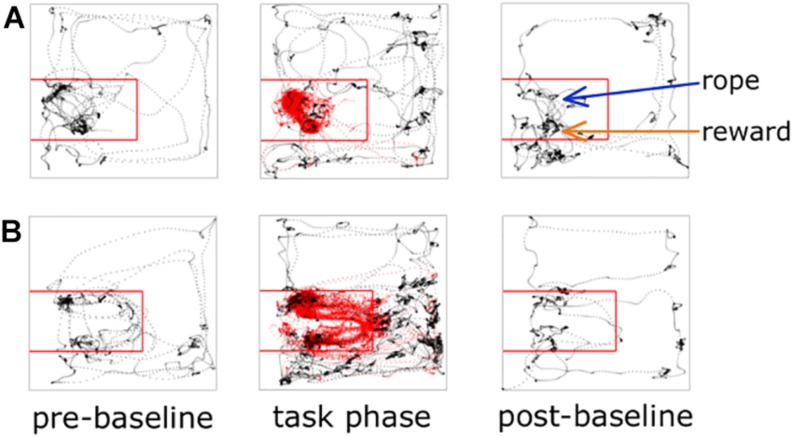
Animal tracking and ROI examples. Tracking data from two different recording sessions are shown; panel (A) is a session from an early iteration of the task where there is no wall between the rope and reward, panel (B) illustrates a session where the wall is present. The on-task ROI is outlined with the red square. Rat tracking data are shown as black dots if off-task and red dots if on-task.